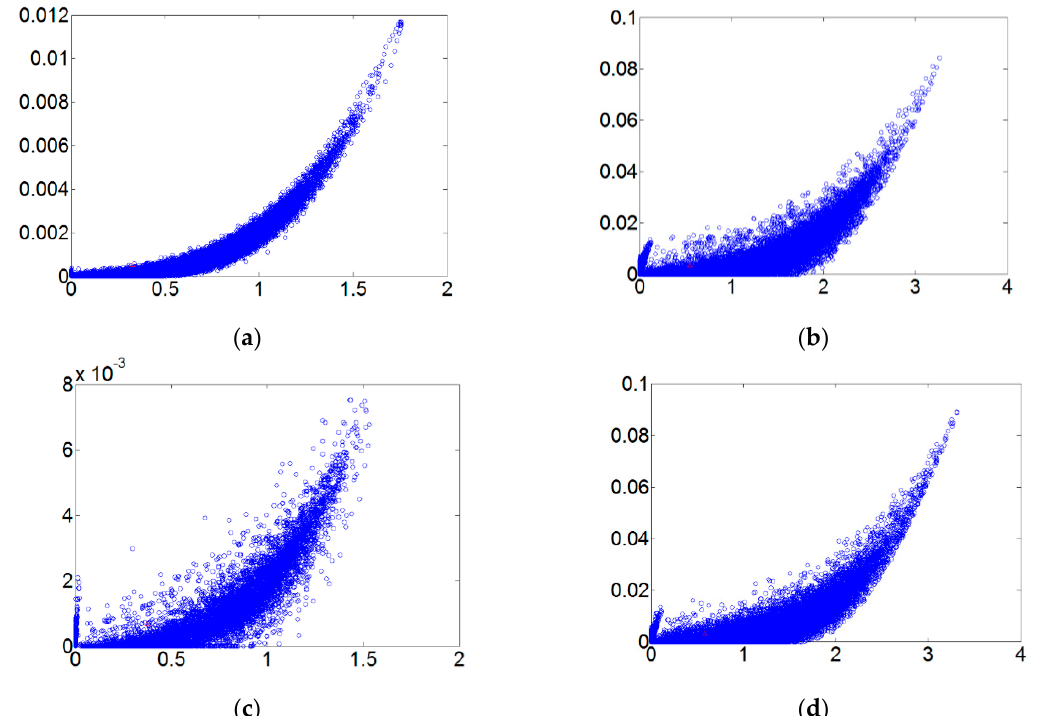
Figure 8. The order 0.5 fault dynamic error trace diagrams for all fault diameters. ( a ) Normal state; ( b ) fault diameter = 0.007; ( c ) fault diameter = 0.014; ( d ) fault diameter = 0.021.